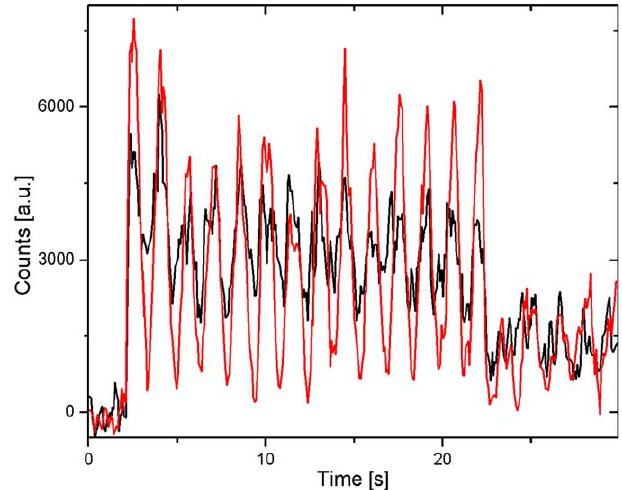
Figure 5. Fluorescence Polarization Studies of Dye-Labeled, Stalled- Packaging Complexes Dye-labeled, stalled-packaging complexes were attached to the surface of a flow chamber and excited using the total internal reflection microscope. The excitation polarization was rotated between s- and p- polarization with a frequency of 0.7 Hz. The emitted fluorescence was separated into s- and p-polarization, respectively, and simultaneously detected (black and red). The dye bleached after 22 s. The integration time per data point was 75 ms. a.u., arbitrary units.